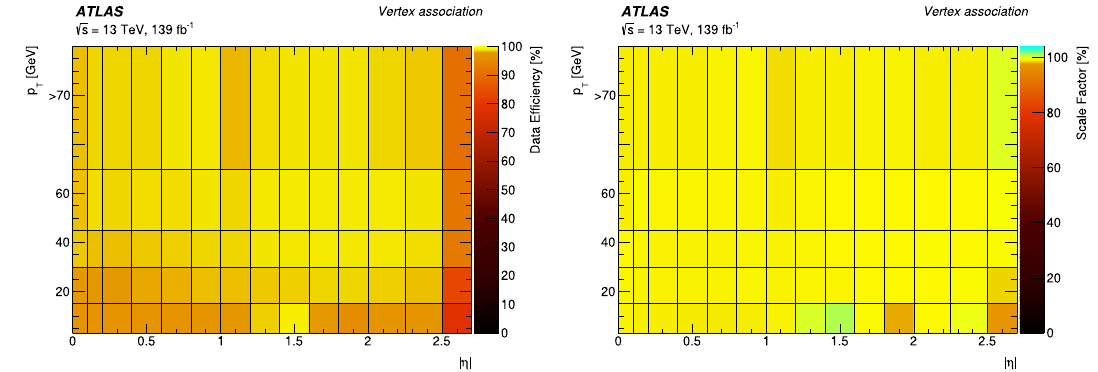
Fig. 18 Efficiency of the vertex association criteria measured in data (left), and the data/MC efficiency scale factor (right) as a function of p T and | η | for muons with p > 3 GeV in Z → μμ T